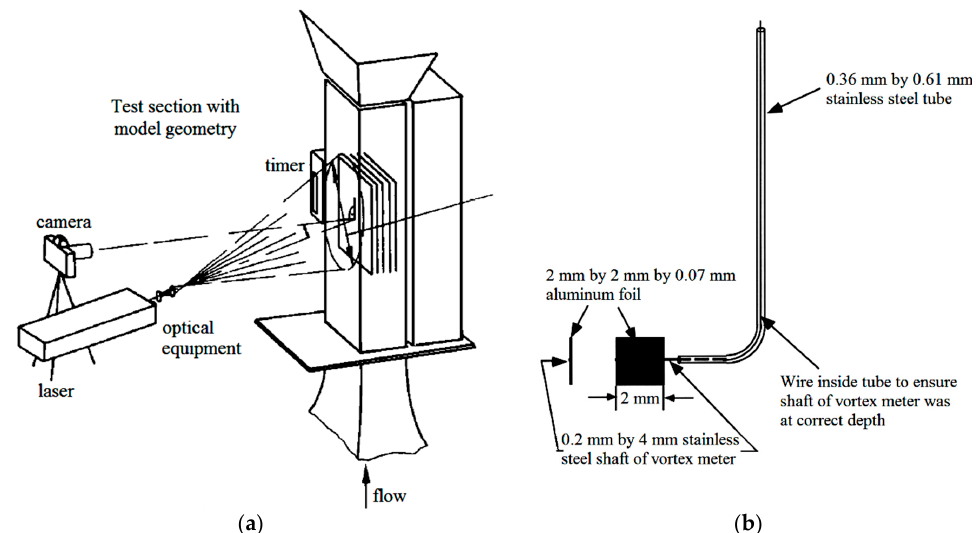
Figure 3. Experiment techniques. ( a ) LLS method [24,35]. ( b ) Vane-type vortex meter used by Gentry and Jacobi [35].